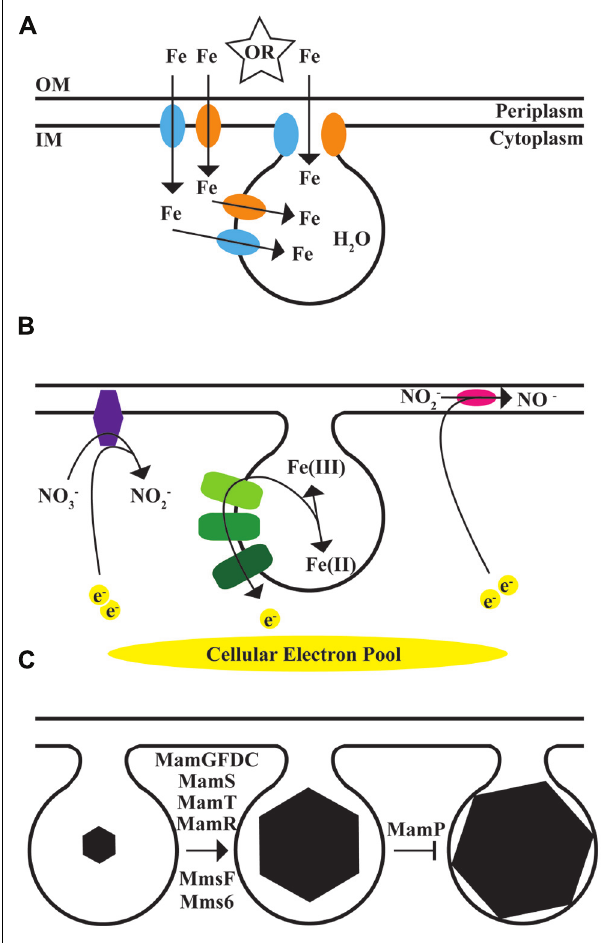
FIGURE 3 |The magnetosome model. Biomineralization in MTB occurs within a membrane compartment derived from the inner membrane. (A) , Source of the mineral. Iron transporters, including FeoB1, blue, and FeoB2, orange, transport iron for magnetite synthesis. Iron either comes through the inner membrane into the cytoplasm and then through the magnetosome membrane into the compartment, or is transported directly from the periplasm to the magnetosome. Other unidentified transport systems are expected to be involved.Water is the source for the oxygen. OM, outer membrane; IM, inner membrane. (B) , Chemistry and Regulation of mineral state. Members of the magnetochrome transport chain, in green, transport electrons to or from iron. Nap, purple, and Nir, magenta, use electrons to reduce nitrate or nitrite. (C) , Regulation of mineral size and shape. In addition to mms6, described here, mamGFDC (Scheffel etal., 2008), mamS, mamT, and mamR (Murat etal., 2010) as well as mmsF (Murat etal., 2012) have all been shown to promote the growth of magnetite crystals to the correct shape and size. MamP appears to limit crystals from growing too large (Murat etal.,